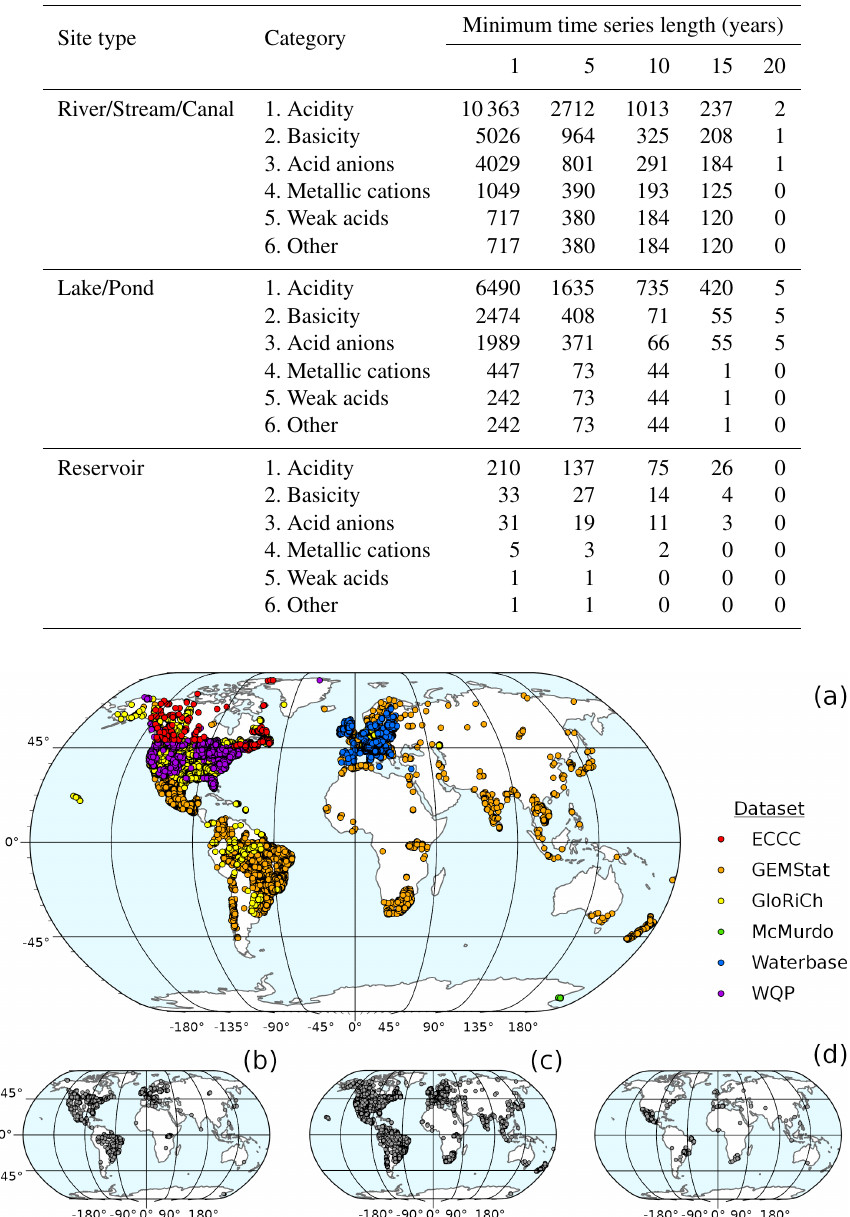
Table 3. Sample size (sites) for waterbody types based on available parameters and time series duration. Sites included in consecutive parameter categories also meet all of the prior category requirements.